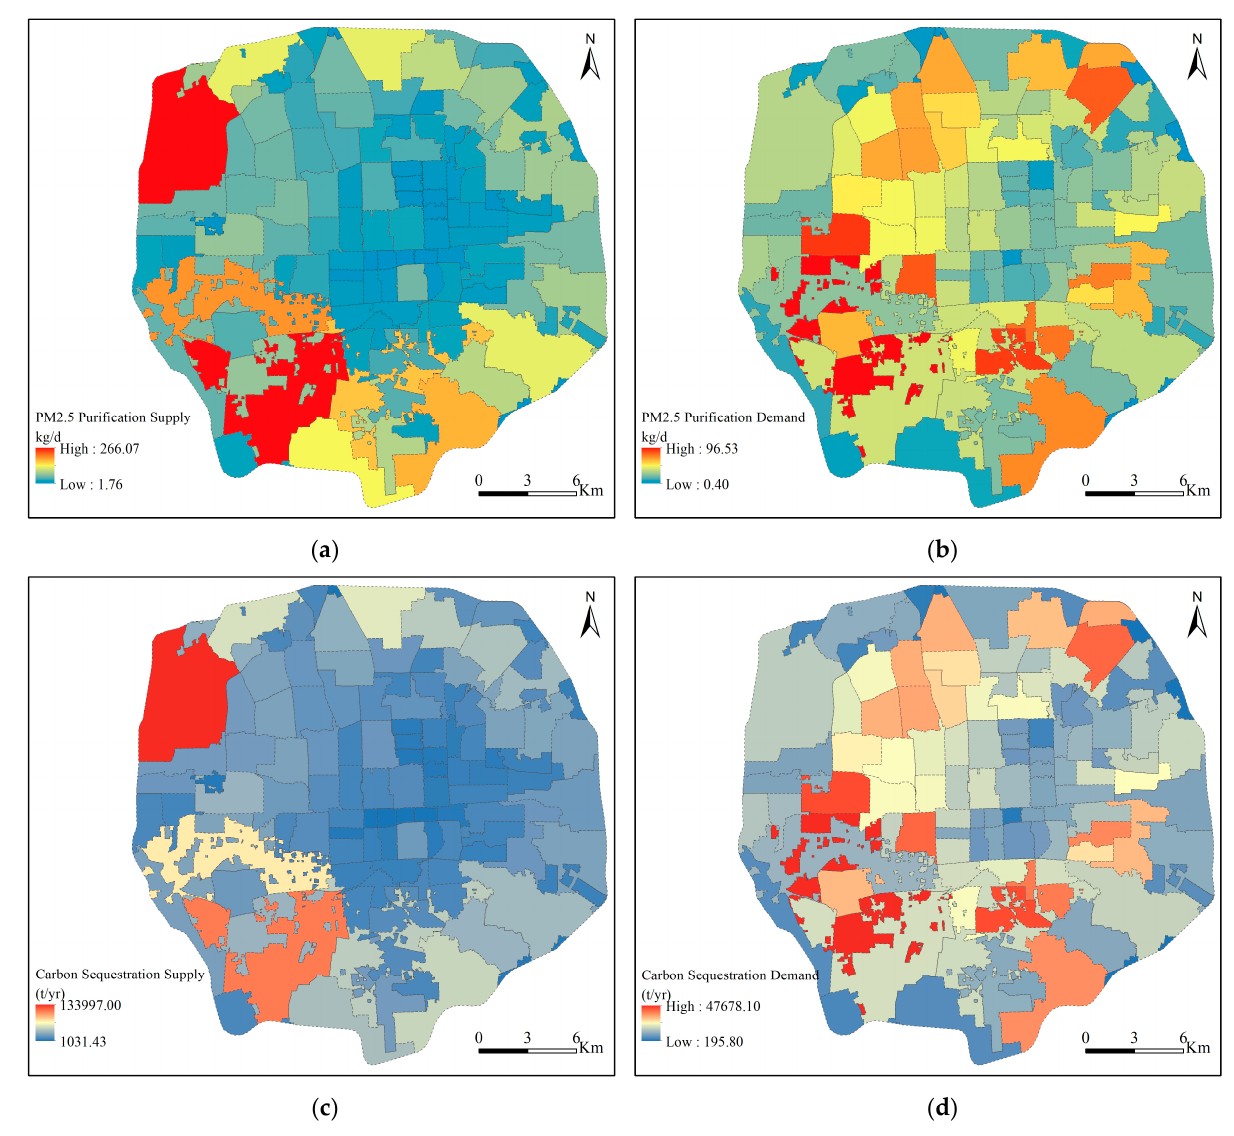
Figure 7. Supply ( a ) and demand ( b ) for purification of particulate matter with an aerodynamic diameter < 2.5 µm (PM 2.5 ); supply ( c ) and demand ( d ) for carbon sequestration for the region within the 5th Ring Road of Beijing at administrative unit scale.